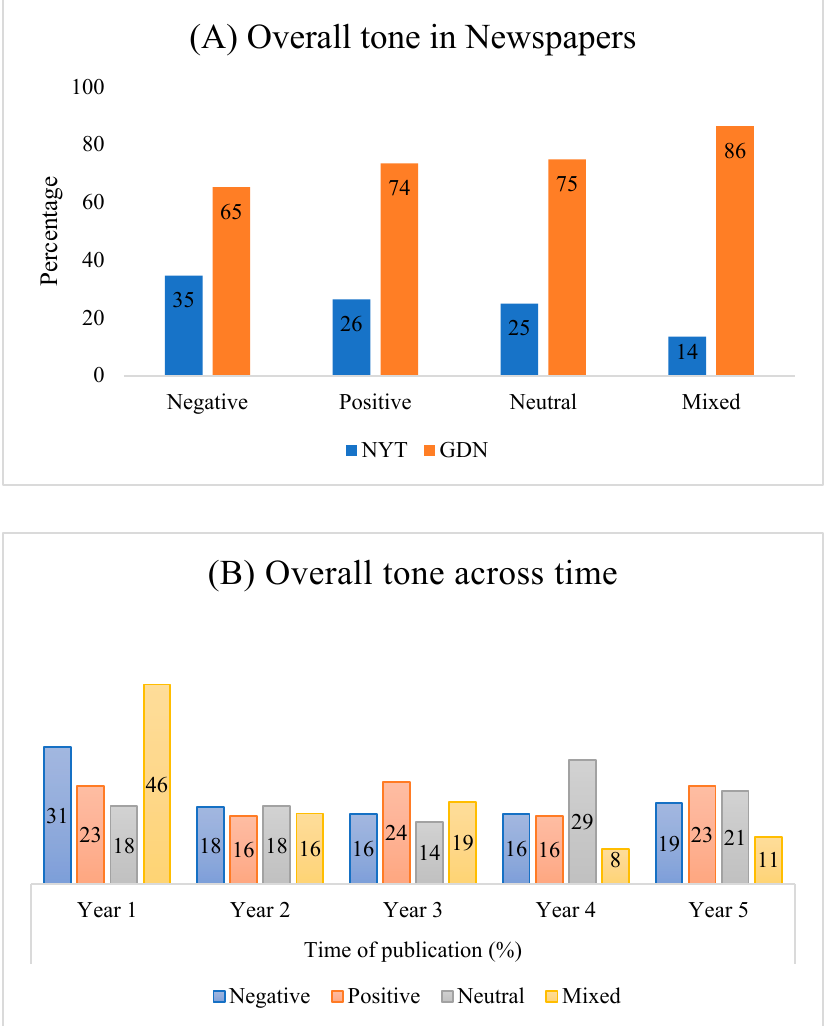
Figure 3. Overall tone in NYT and GDN from Year 1 to Year 5. ( A ) Overall tone in NYT and GDN, including negative, positive, neutral, and mixed. ( B ) Overall tone of different categories across time from both NYT and GDN.